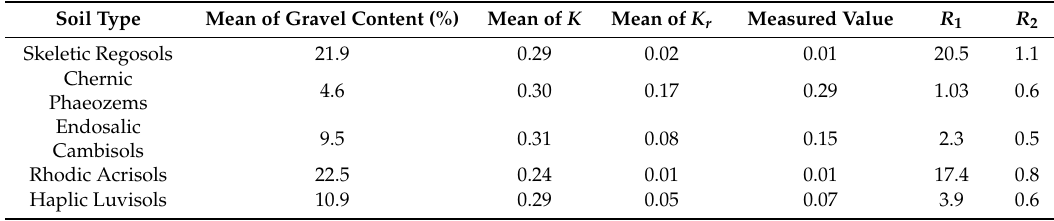
Figure 5. The K values and K r values for each soil types. Table 3. Comparison of calculated and measured soil